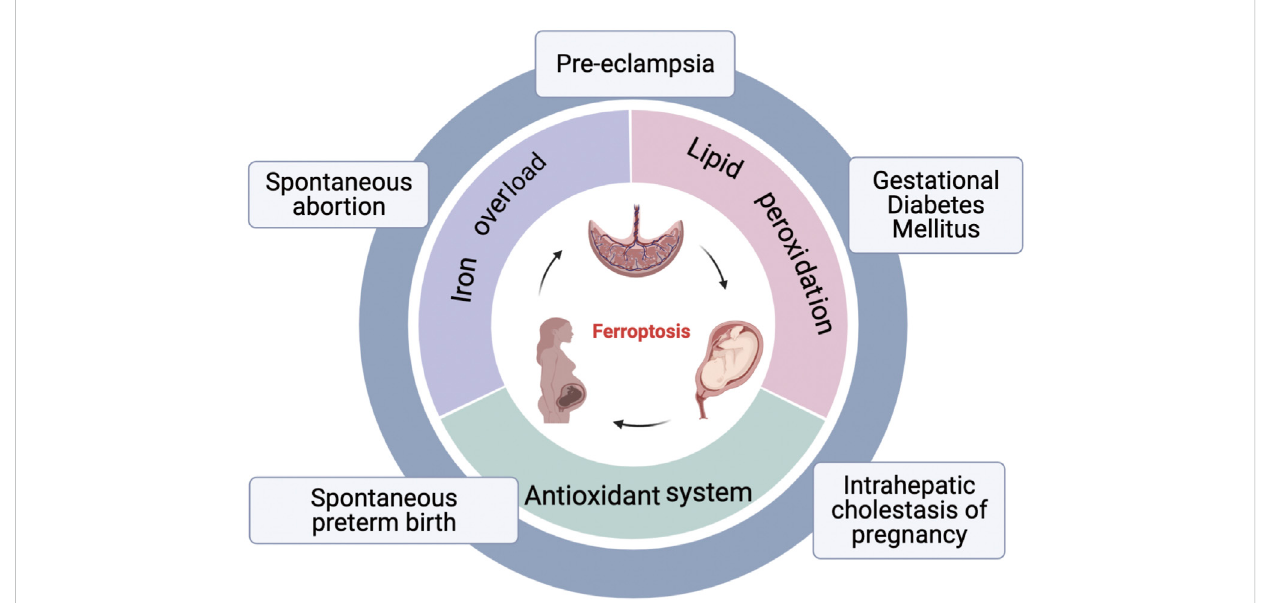
FIGURE 2 An overview of ferroptosis and pregnancy related diseases. Three hallmarks of ferroptosis: lipid peroxidation, iron overload, and disorder of antioxidant systems; Pregnancy related diseases associated with ferroptosis: spontaneous abortion, pre-eclampsia, gestational diabetes mellitus, intrahepatic cholestasis of pregnancy, spontaneous preterm